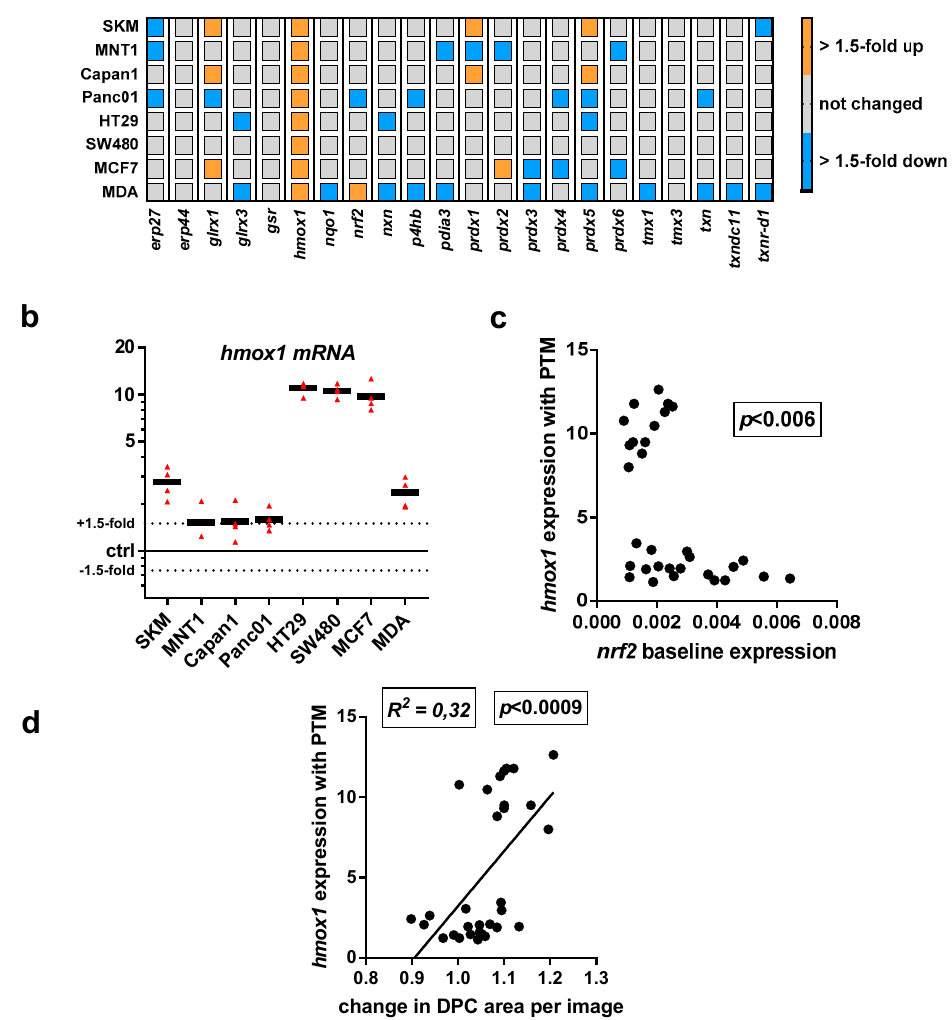
Figure 4. Exposure to PMT modulated transcriptional levels of several redox-related proteins with a consistent increase in hmox1 transcripts across all eight human cancer cell lines investigated. Gene expression of redox-related enzymes, with upregulation of glrx1 and hmox1 , and a mixed response for peroxiredoxin genes, especially prx1 and prx5 . ( a ) qPCR of all target transcripts as fold change of PTM-treatment over medium control; ( b ) detailed expression levels of hmox1 in all cell lines investigated; ( c ) relation between hmox1 upregulation with PTM treatment and nrf2 expression of cells incubated with control medium; ( d ) correlation of total cytosolic area determined as DPC area in high-content imaging experiments 4 h post plasma-treatment and expression of hmox1 . Data are from three to four independent experiments. ( b ) each triangle and ( c , d ) each dot represents one biological replicate of one cell lines for the indicated markers.